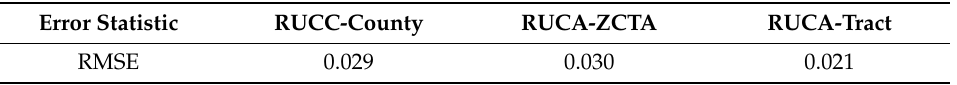
Table 5. RMSE of ORs for integer rural-urban codes as compared to the continuous rurality